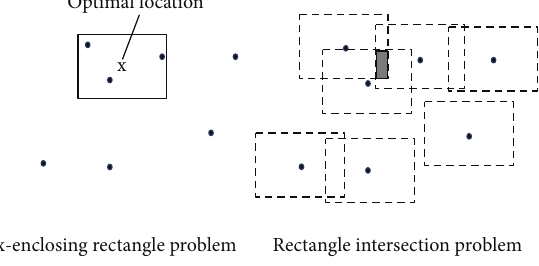
Figure 4: Example of transformation.